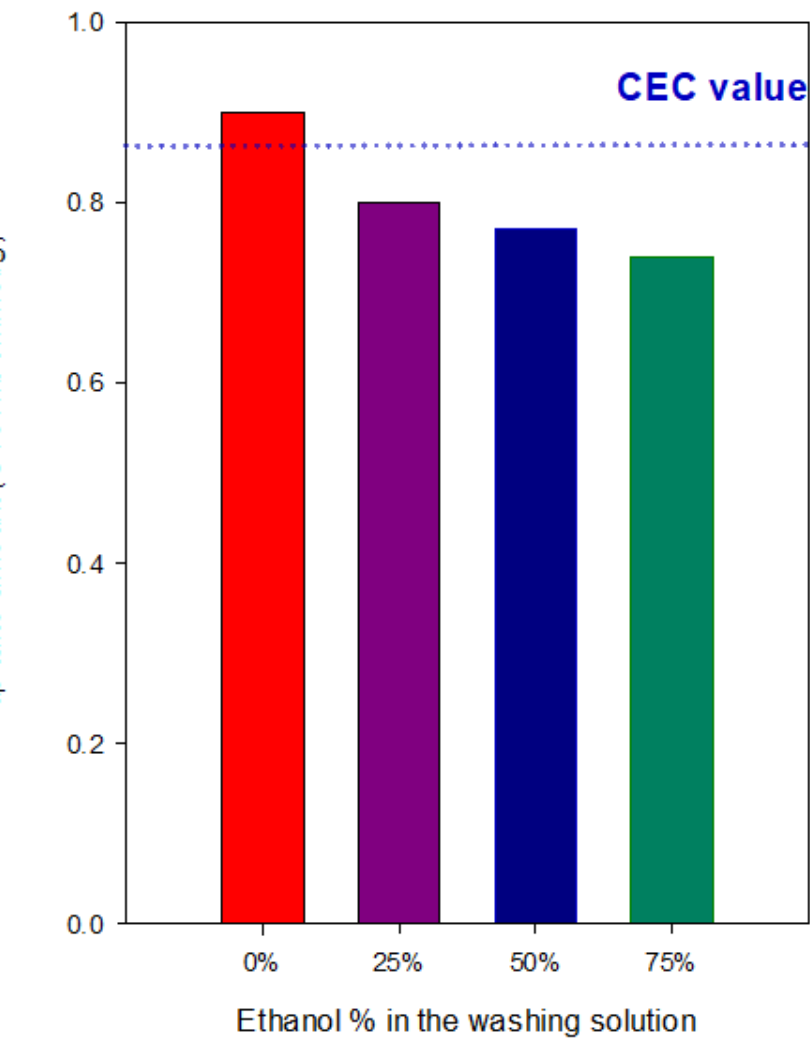
Figure 1. E ff ect of the ethanol content in the washing solution of the organoclay.